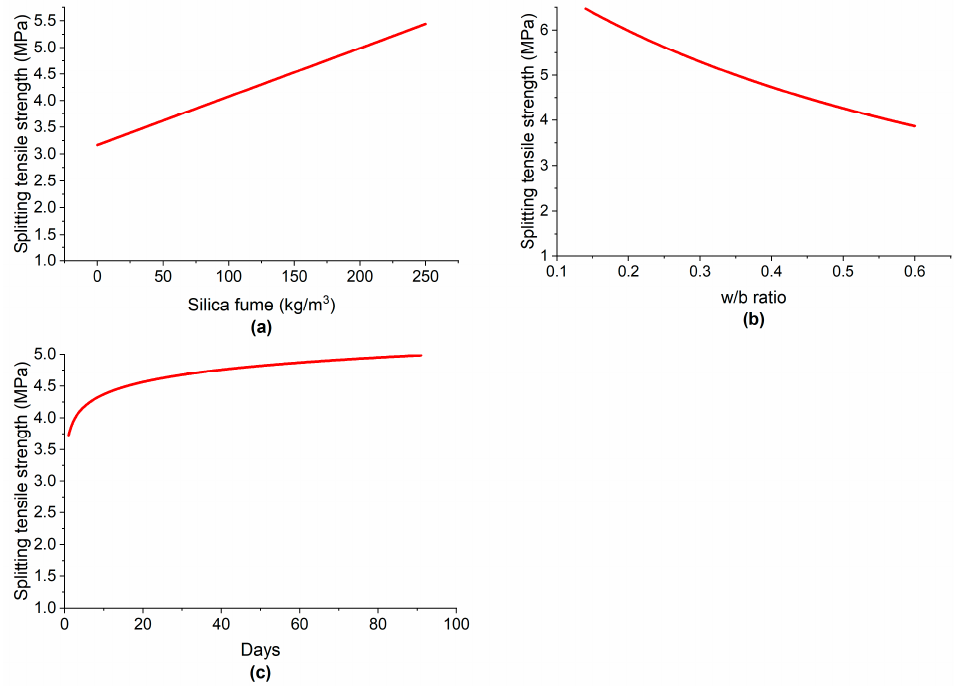
Figure 11. Variation in STS with: ( a ) silica fume; ( b ) w/b ratio; ( c ) curing time.